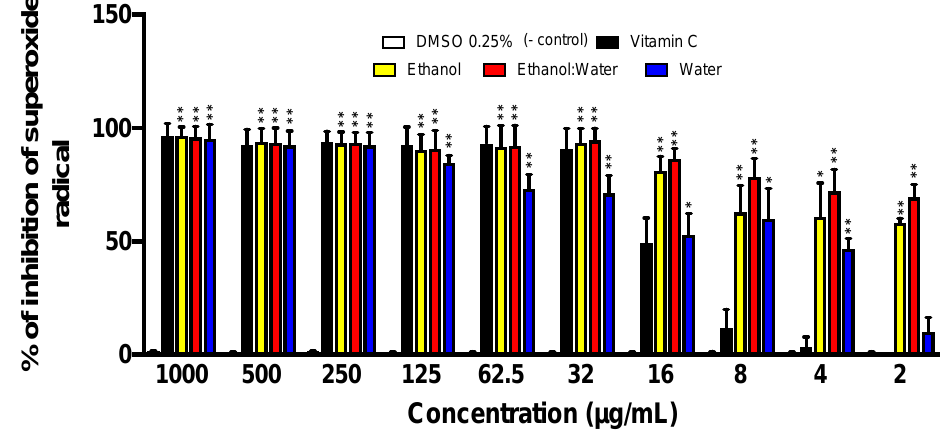
Figure 4. Superoxide scavenging activity of three LT extracts at different concentrations (1000 µg/mL– 2 µg/mL) after 20 min incubation. Each bar represents the average of three replicates and the error bars represent the standard deviation. The asterisks indicate a significant difference between the treatment and negative control (* p < 0.05 and ** p < 0.001).